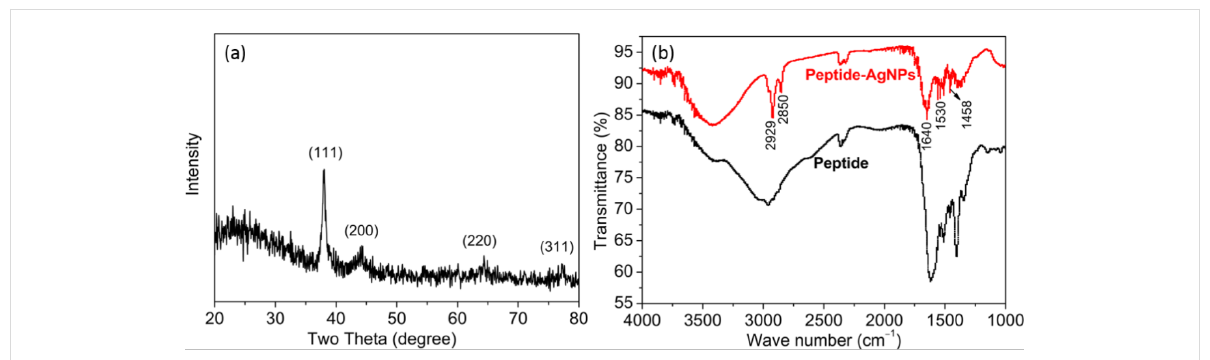
Figure 3: (a) XRD pattern and (b) FTIR spectra of casein peptide-capped silver